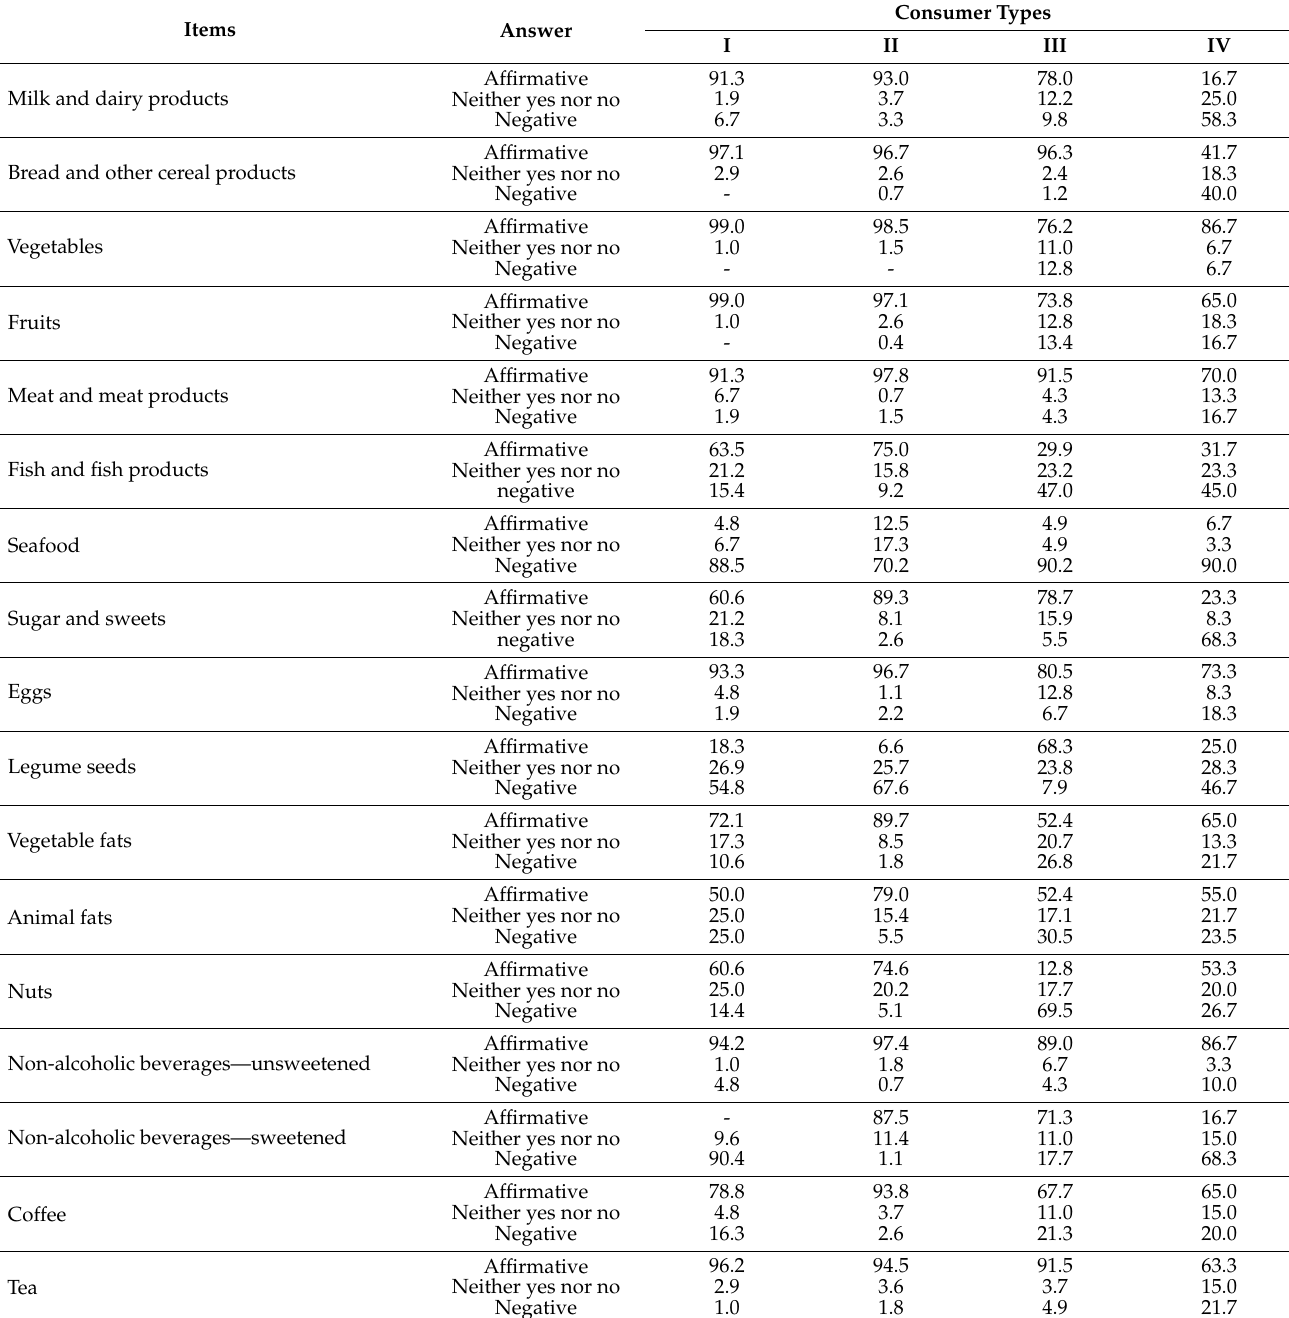
Table 4. Characteristics of the types of Polish consumers by consumed food and non-alcoholic beverages ( n = 600, in